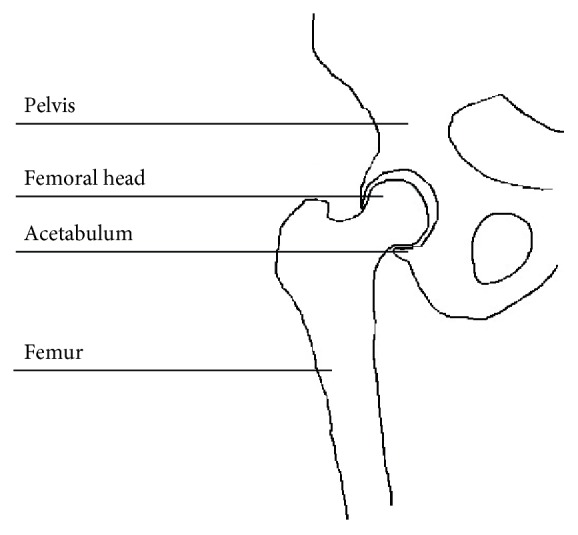
Human hip joint anatomy.